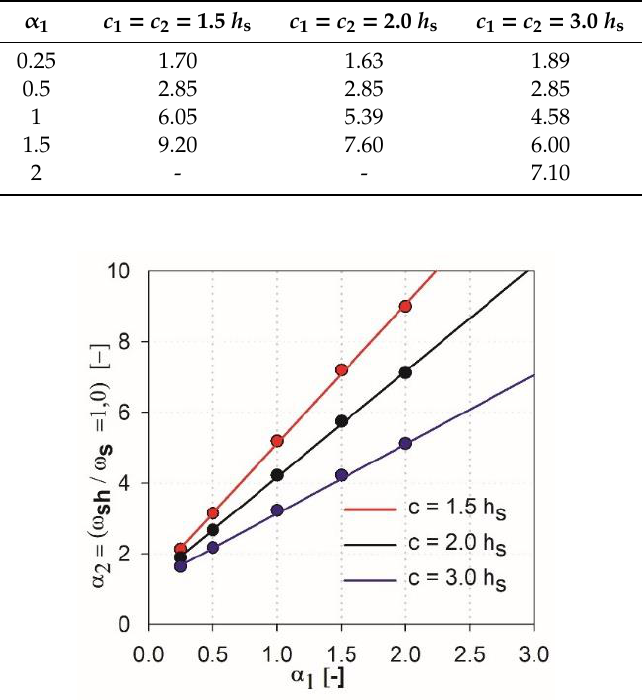
Table 3. Minimum values of the parameter α 2 , which satisfies the condition (2)—ACI318.